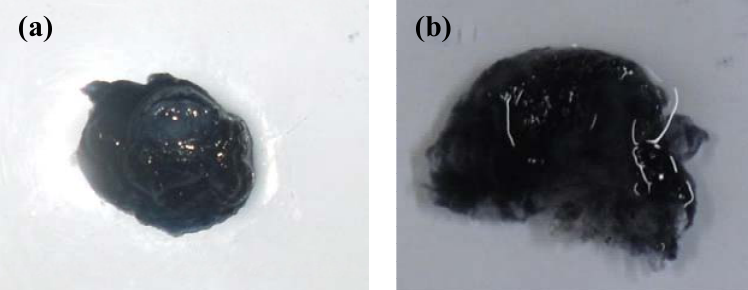
Figure 4 . Digital images showing the ECH ( a ) before electrical stimulation and ( b ) after 30 release cycles.